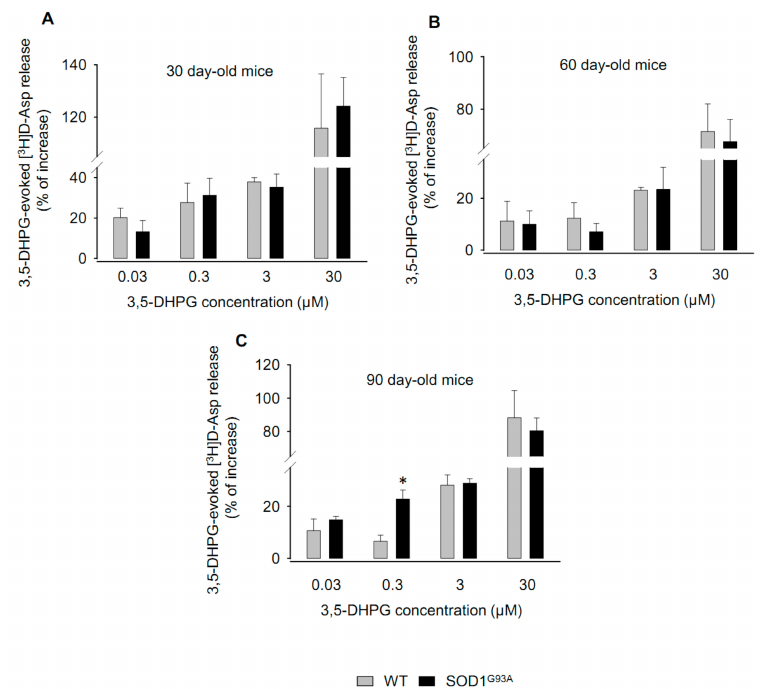
Figure 1. Release of [ 3 H] d -Aspartate ([ 3 H] d -Asp) in spinal cord synaptosomes purified from wild type mice (WT) and SOD1 G93A mice. The e ff ect of ( S )-3,5-dihydroxyphenylglycine (3,5-DHPG) on the spontaneous release of [ 3 H] d -Asp was measured in spinal cord synaptosomes prepared from SOD1 G93A mice at di ff erent stages of the disease: ( A ) 30 days of life, ( B ) 60 days of life, and ( C ) 90 days of life, corresponding to pre-symptomatic (30 and 60 days) and early-symptomatic (90 days) phases of the disease. Age-matched WT animals were used as controls. Synaptosomes were loaded with [ 3 H] d -Asp, in order to label the intra-terminal releasing pools of Glu, and exposed in superfusion to increasing concentrations (0.03, 0.3, 3, and 30 µ M) of 3,5-DHPG. Labelling by [ 3 H] d -Asp did not di ff er significantly between WT and SOD1 G93A mice when normalized for synaptosomal protein. Superfusion samples collected were counted for radioactivity. Results are expressed as the percent increase respect to the basal control release. The data reported are the means ± SEM of five independent experiments (five WT and five SOD1 G93A mice) run in triplicate (three superfusion chambers for each experimental condition). No significance was detected in 30- and 60-day-old mice, while a significant di ff erence was found in 90-day-old SOD1 G93A mice versus WT mice. * p < 0.001 vs. WT (two-way ANOVA followed by Bonferroni’s post-hoc